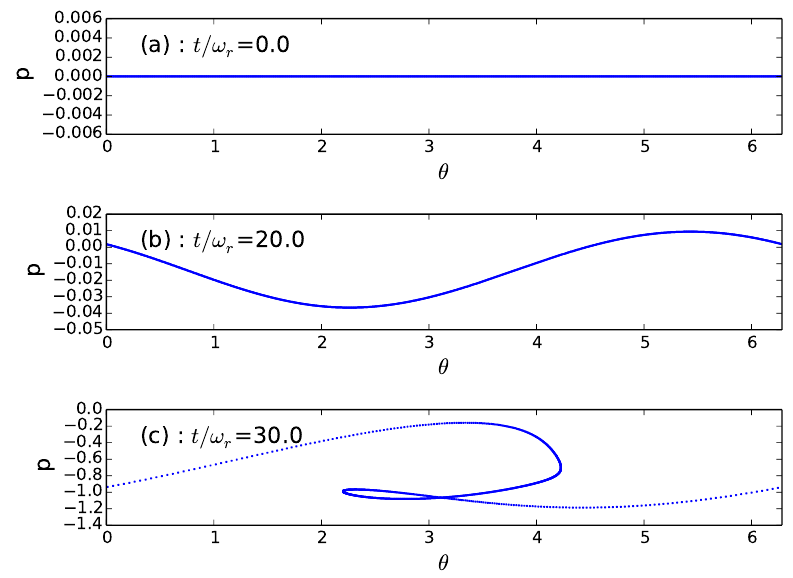
, p ) for each atom j = 1 .. 1000 when ( a ) Figure 7. Snapshots of momentum distribution ( θ j j t = 0 ω − 1 in the case of strong excitation. The parameters , ( b ) t = 20 ω − 1 and ( c ) t = 30 ω − 1 r r r used are as in Figure 6.